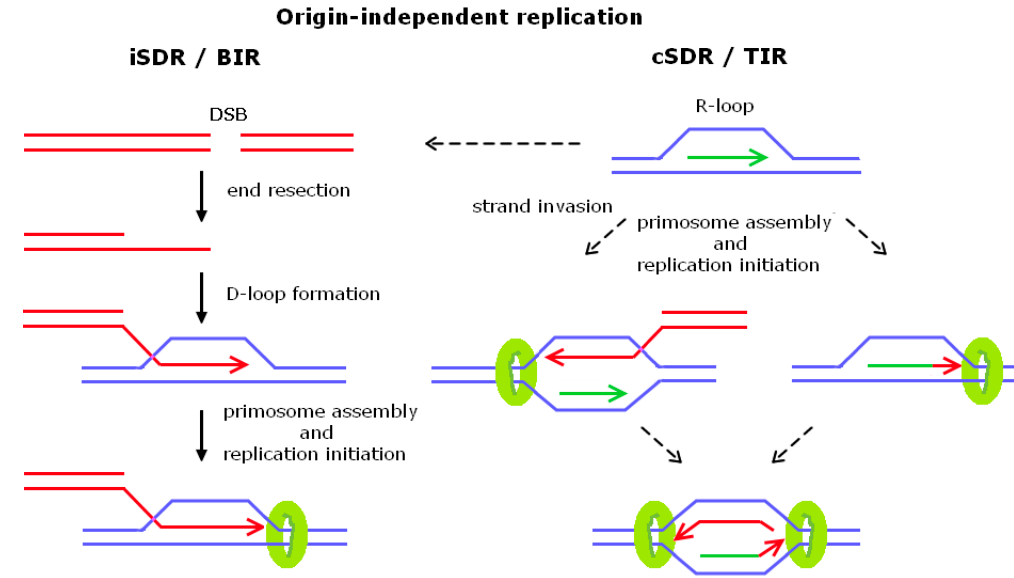
Schematic representation of possible mechanism involved in origin-independent replication initiation by inducible stable DNA replication/break-induced replication (iSDR/BIR) or constitutive stable DNA replication/transcription-initiated replication (cSDR/TIR). Invading and newly synthesized DNA (red), RNA (green), and helicases (green circle) are indicated. Dashed arrows indicate putative scenarios for TIR-dependent replication initiation. Note that none of these scenarios have been experimentally verified. See text for more details. DSB: double-strand break.